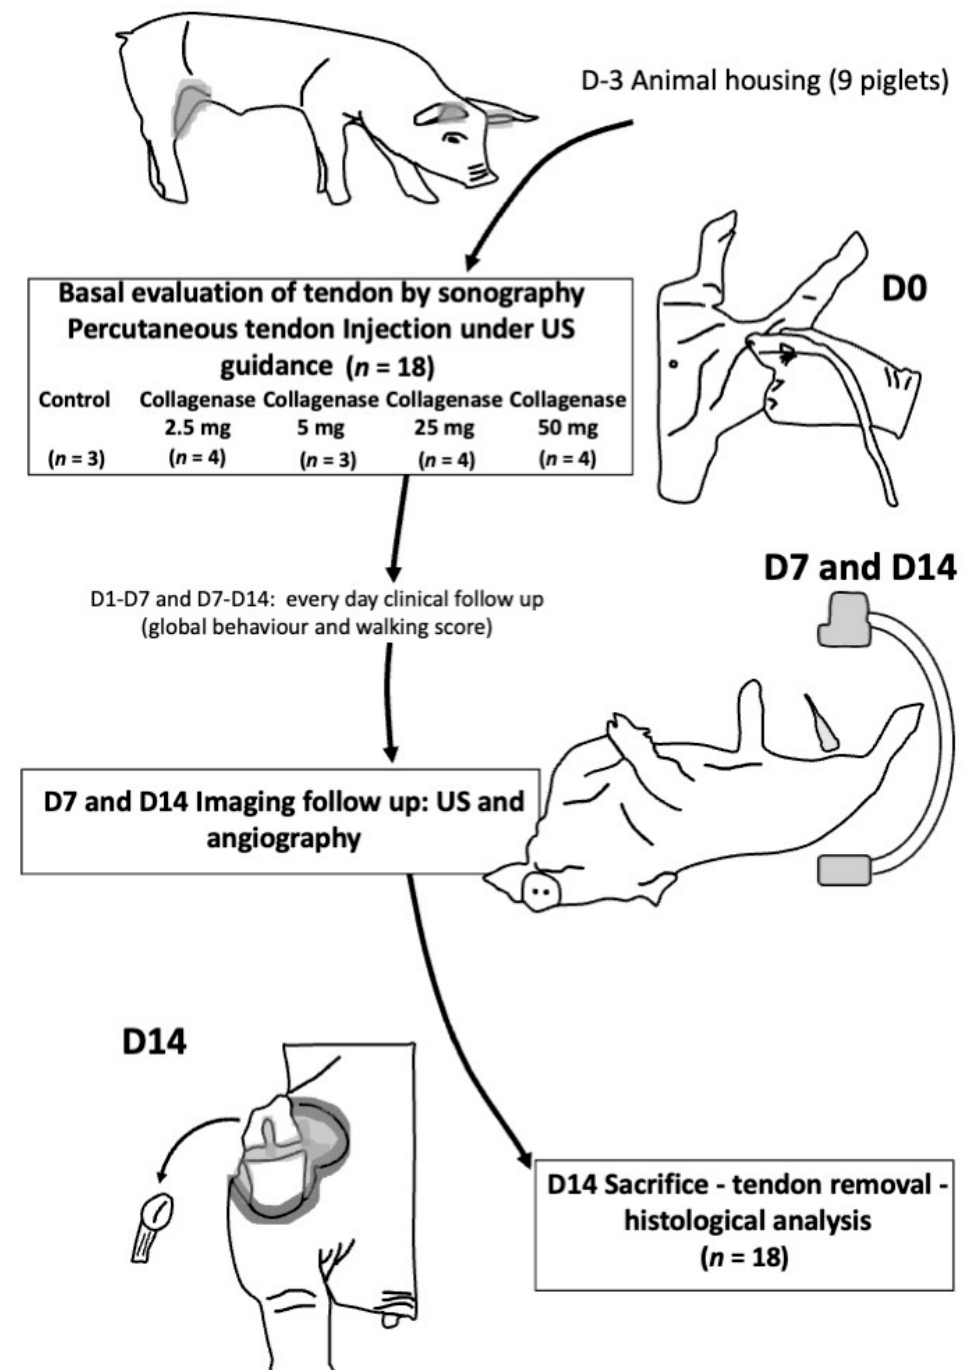
Figure 1. Flowchart of the study. US: ultrasound; D: day. For tendon injection and basal ultrasound evaluation of the tendon at inclusion, pig- lets were sedated with 1 mg Midazolam, 10 mg ketamine and 5 mg azaperone per kilo- gram of body weight. For angiography evaluation and ultrasound follow-up at D7 and D14, piglets underwent general anesthesia, after overnight fasting with free access to wa- ter. They were premedicated with intramuscular injection of 10 mg/kg ketamine, 1 mg/kg midazolam and 0.05 mg/kg atropine. Analgesia was provided by injection of 10 μ g sufen- tanil before the procedure. Anesthesia was induced with a propofol bolus (4 mg/kg) via